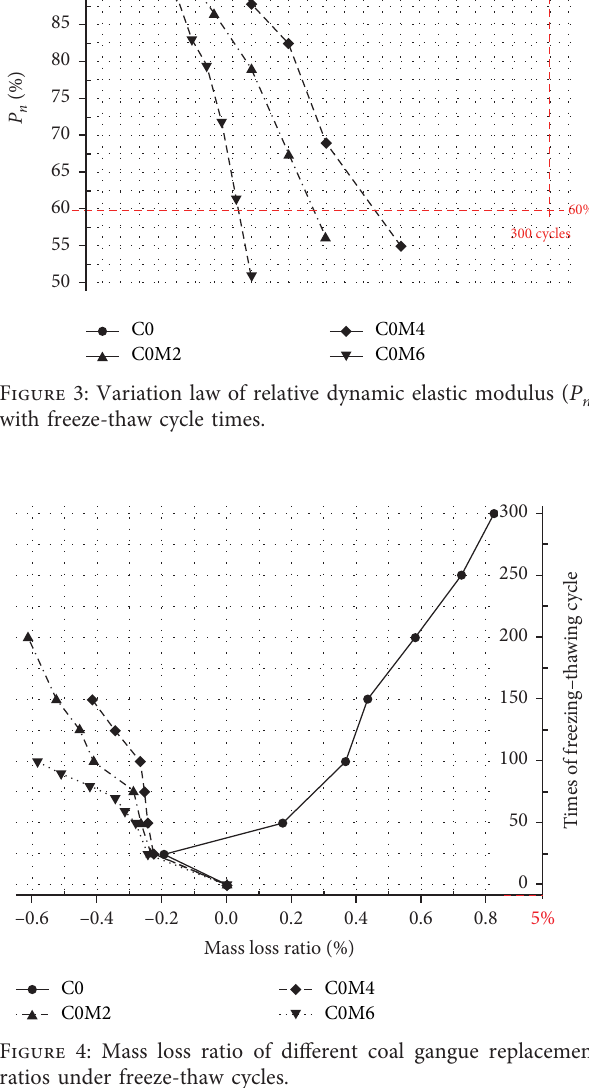
Figure 4: Mass loss ratio of different coal gangue replacement ratios under freeze-thaw